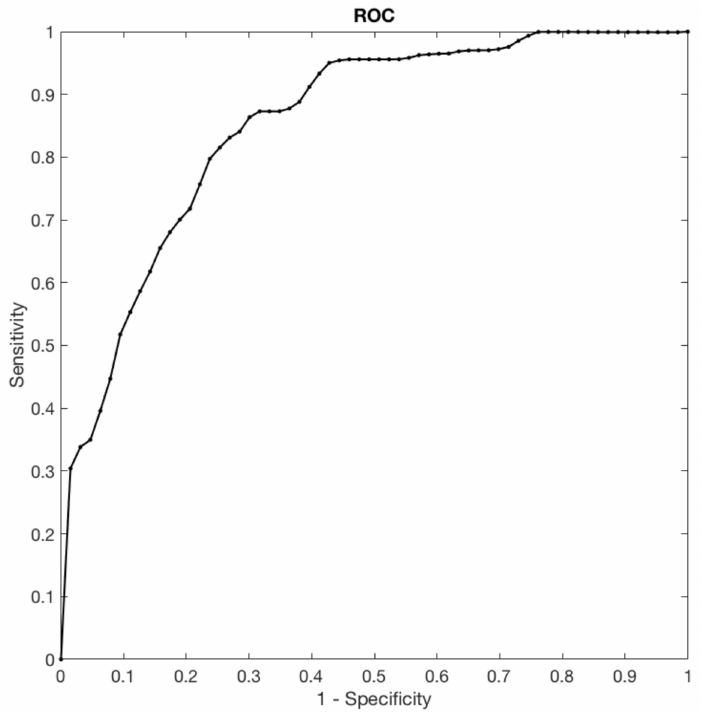
Figure 5. The chart shows the ROC curve which is representative of the classifier